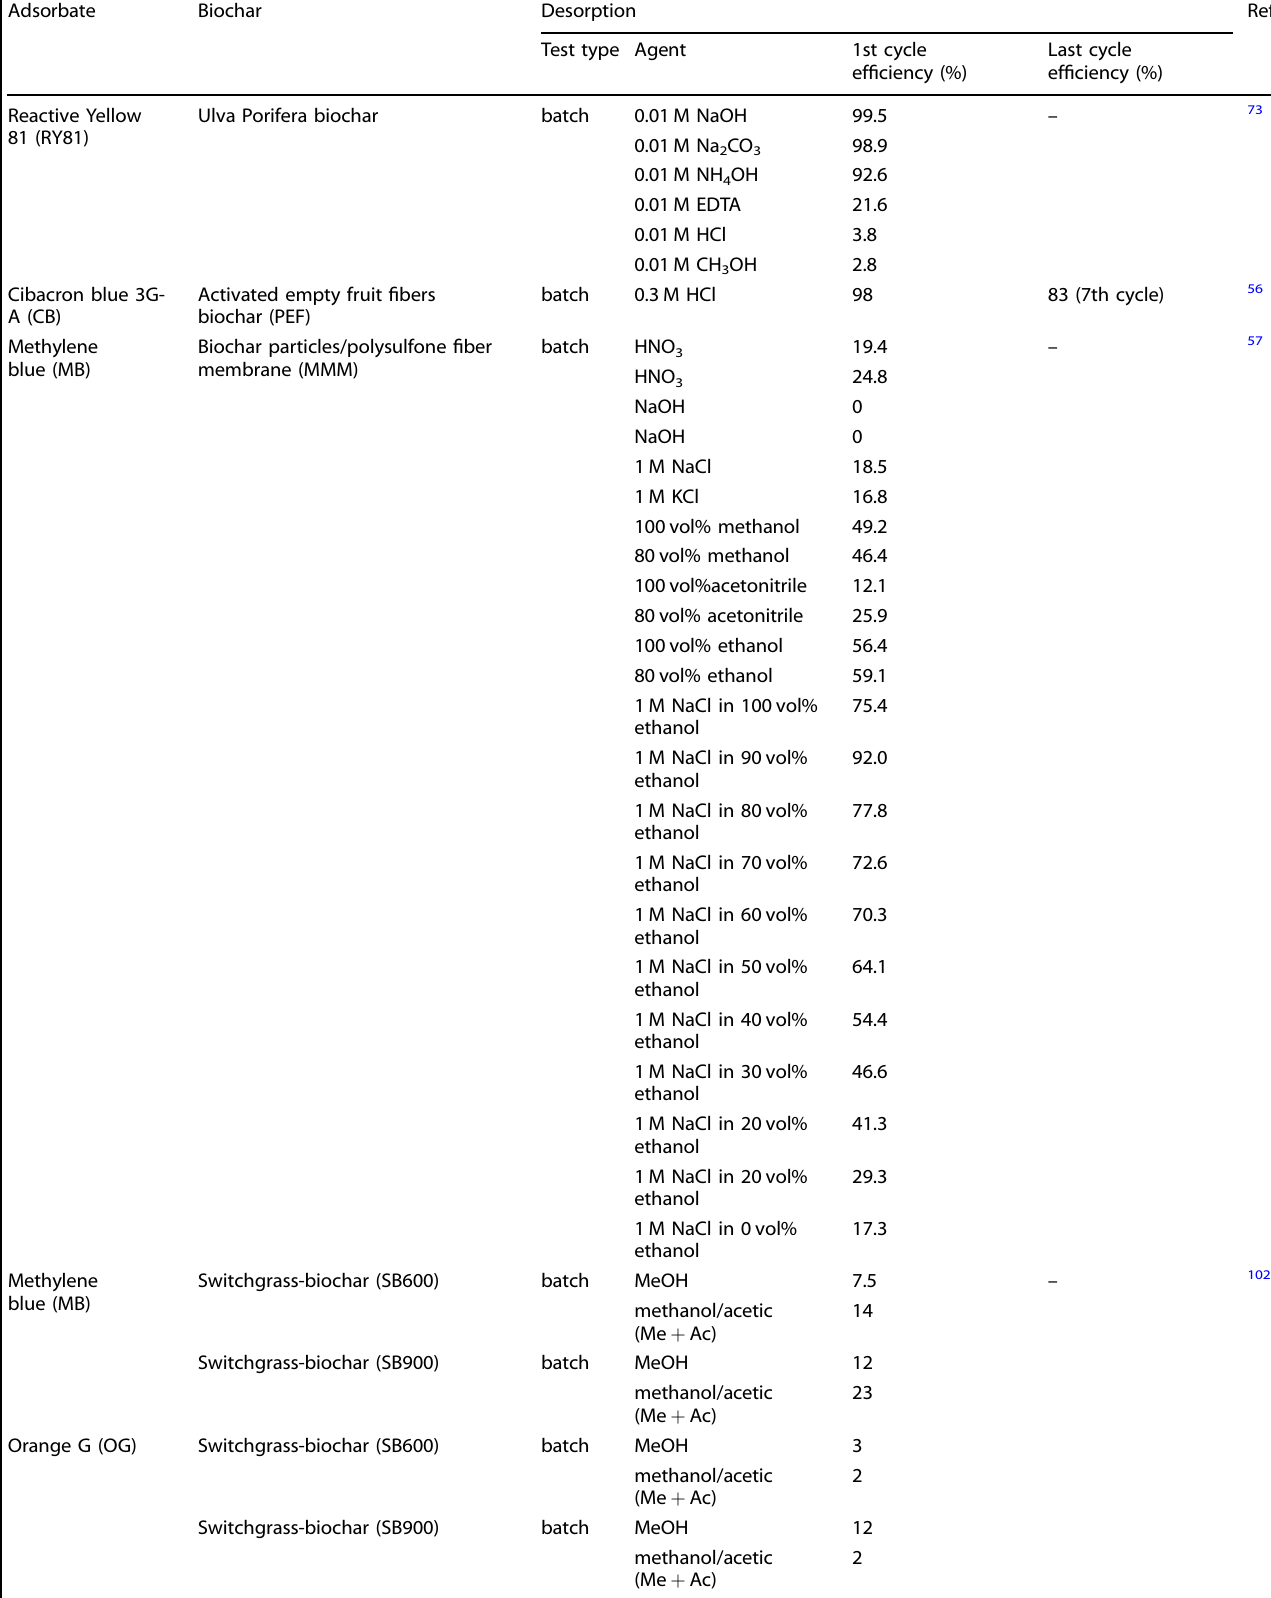
Table 10. Chemical desorption ef fi ciencies of biochar after adsorbing dyes from wastewater.